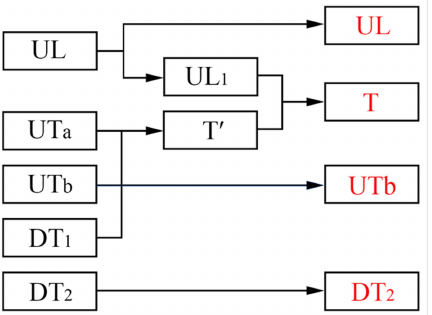
Figure 29. The schematic diagram of vortex evolution in UL-T- UTb-DT mode. Table 4. Summary of vortex shedding